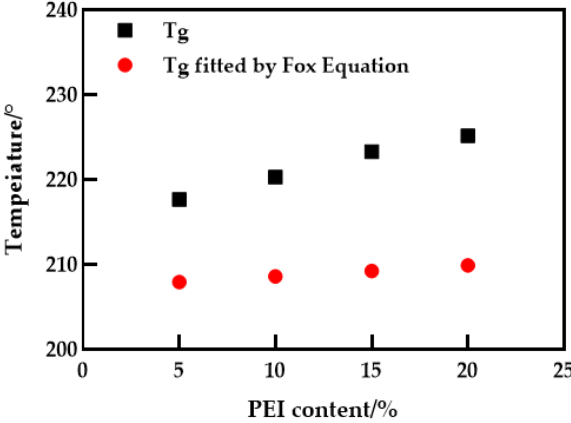
Figure 3. Theoretical and measured values of the glass transition temperature of the blending sys- tem.